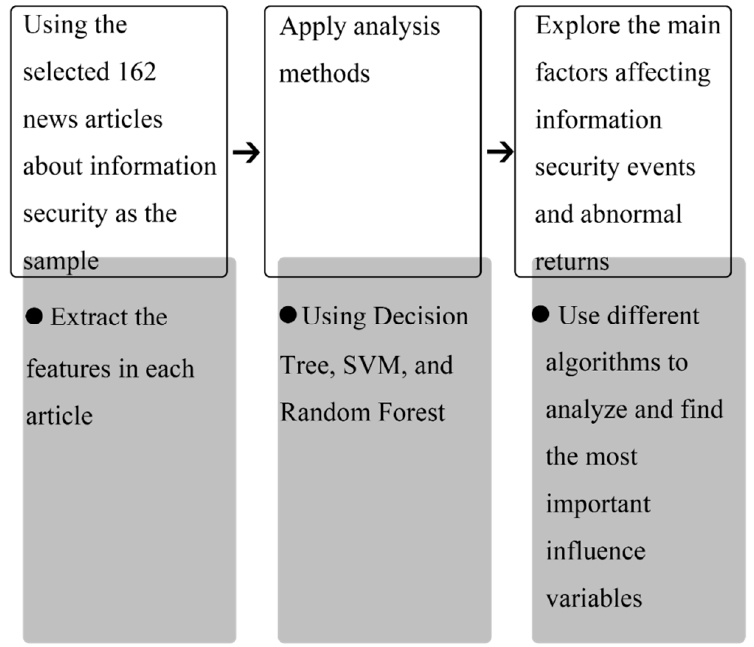
Figure 3. Steps for content analyzing information security events.